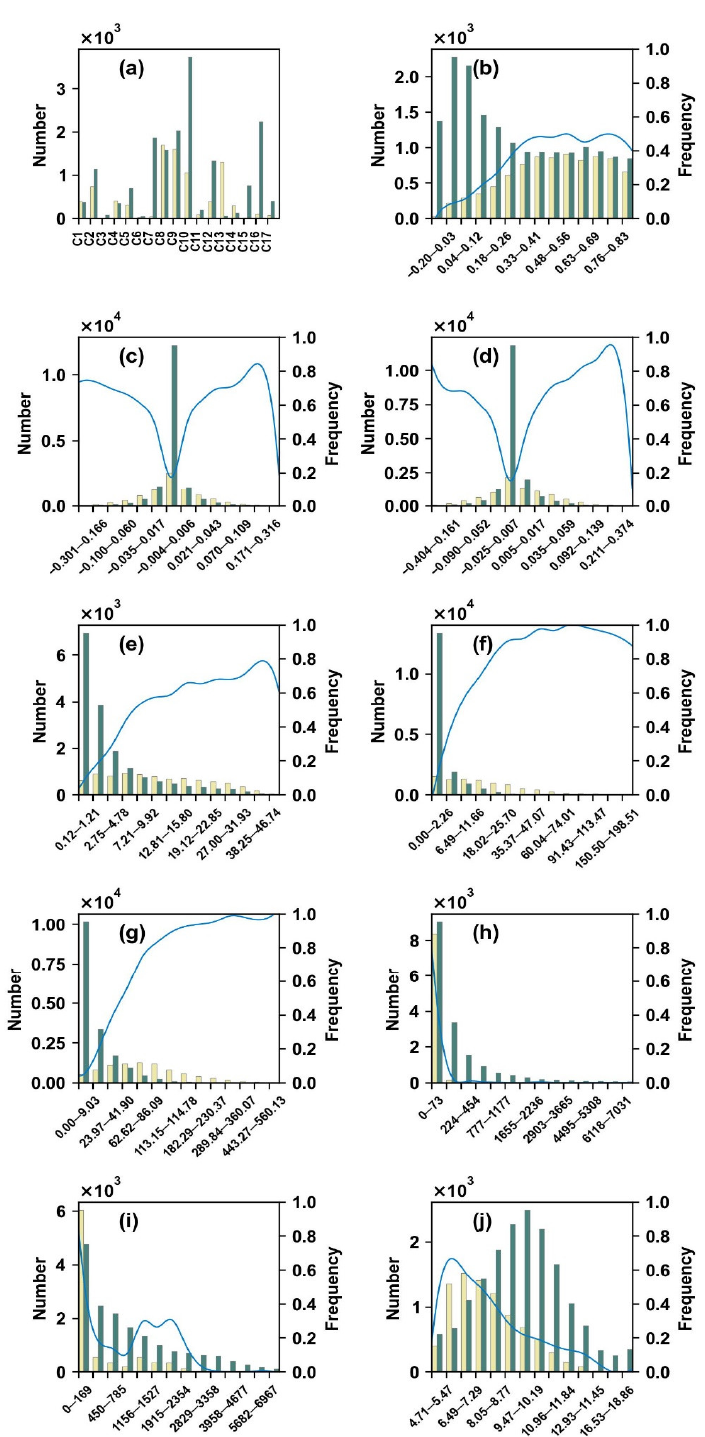
Figure 7. Relationship between samples and landslide conditioning factors, ( a ) land cover ( b ) NDVI ( c ) plan curvature ( d ) profile curvature ( e ) slope (°) ( f ) Pr1d (mm) ( g ) Pr7d (mm) ( h ) distance to road (km) ( i ) distance to fault (km) ( j ) TWI.